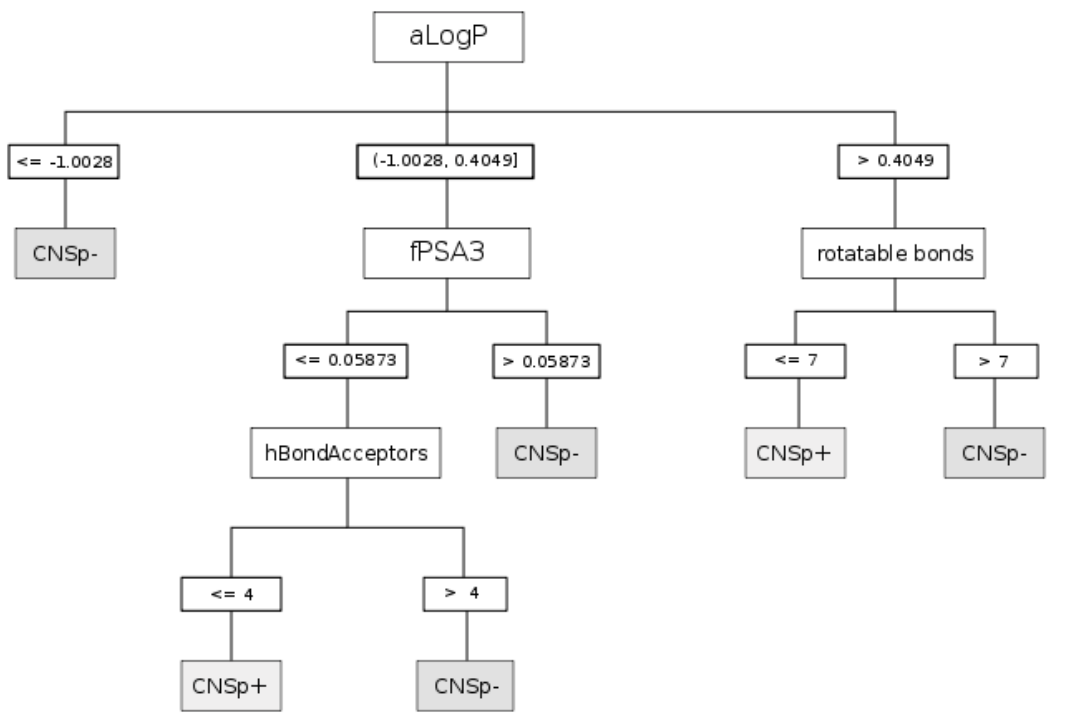
Figure 1. Decision tree built with the chi-squared automatic interaction detector (CHAID) on CDK descriptors. Prediction of strong (CNSp+, grey boxes) or weak (CNSp − , grey boxes) blood-brain barrier permeation is based on the splitting criteria (white boxes) of the partition coefficient (aLogP), rotatable bonds count, charge weighted partial positive surface area divided by total molecular surface area (fPSA3), and hydrogen bond acceptor count (hBondAcceptors).